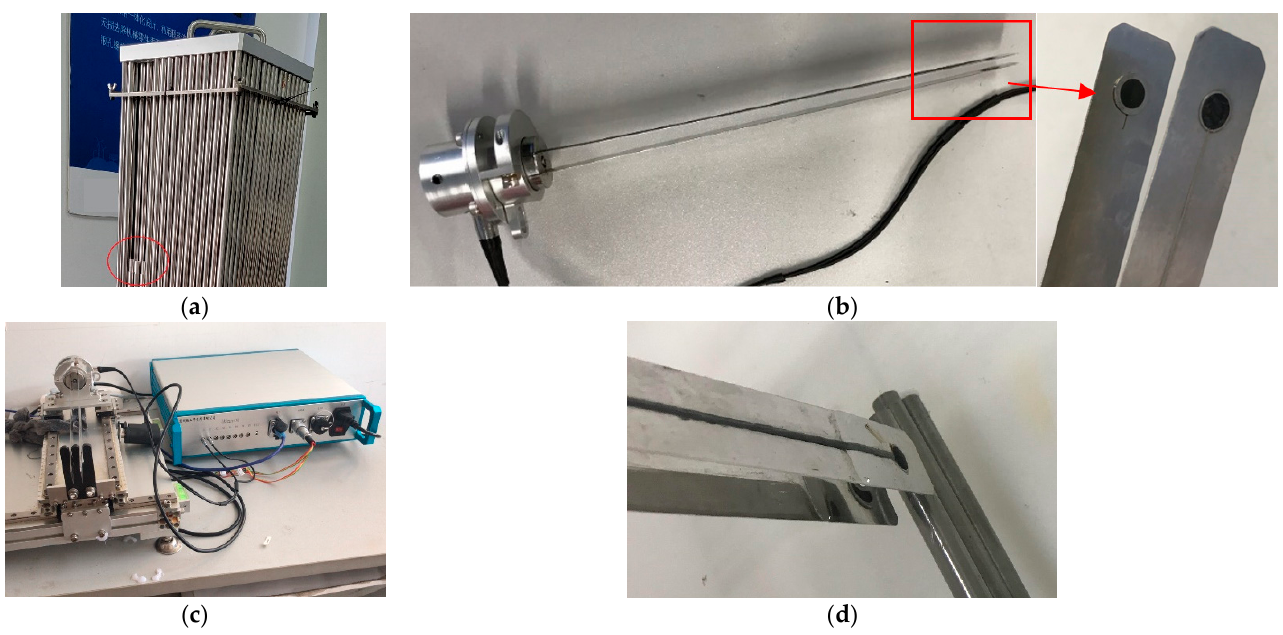
Figure 6. ( a ) The FA specimen; ( b ) the fabricated transducers; ( c ) the mechanical device and instru- ment; ( d ) the transducers are coupling with rods. Table 1. The acoustic parameters calculated by proposed method. Frequency